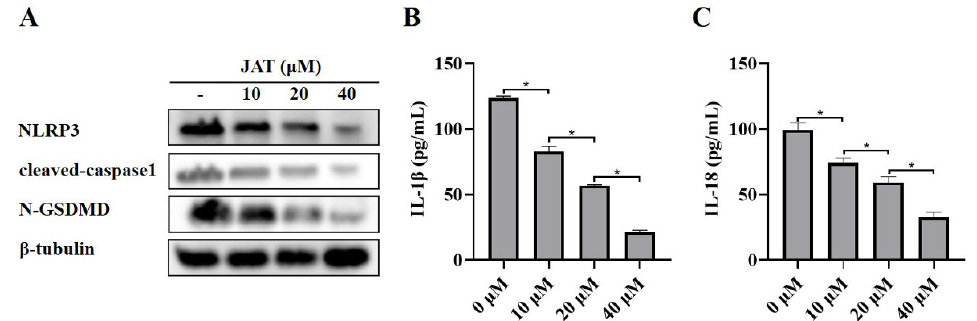
Figure 3. JAT inhibits MNV-infection-induced NLRP3 inflammasome activation in RAW264.7 mac- rophages. RAW264.7 macrophages infected with MNV for 24 h and treated with JAT for 48 h were lysed, and the culture supernatants were collected. ( A ) The cell lysates were immunoblotted for NLRP3, cleaved-caspase1, N-GSDMD, and β-tubulin. ( B , C ) The cell culture supernatants were ana- lyzed for secreted IL-1β and IL-18 levels by ELISA. * p < 0.05.